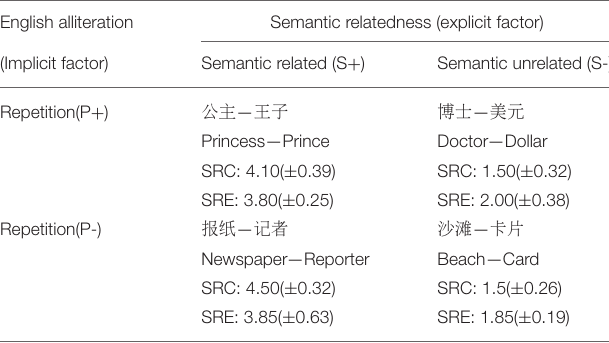
TABLE 1 | Experimental design and stimuli examples. English